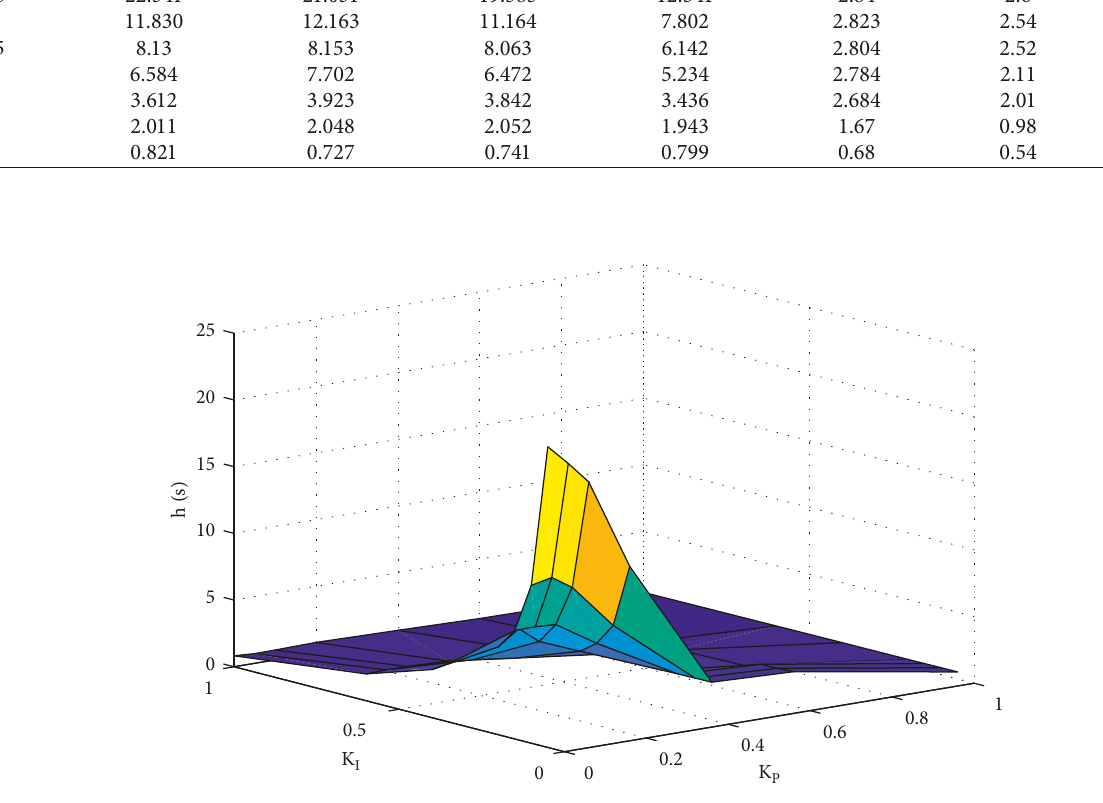
Table 6: Delay margin h ∝ ( K